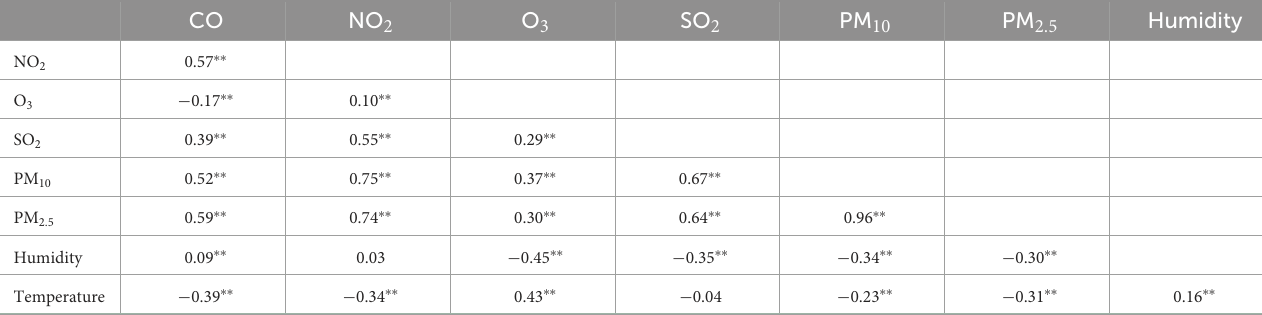
TABLE 2 Spearman’s correlations between daily average air pollution concentrations and meteorological factors during the study period. CO NO 2 O 3 SO 2 PM